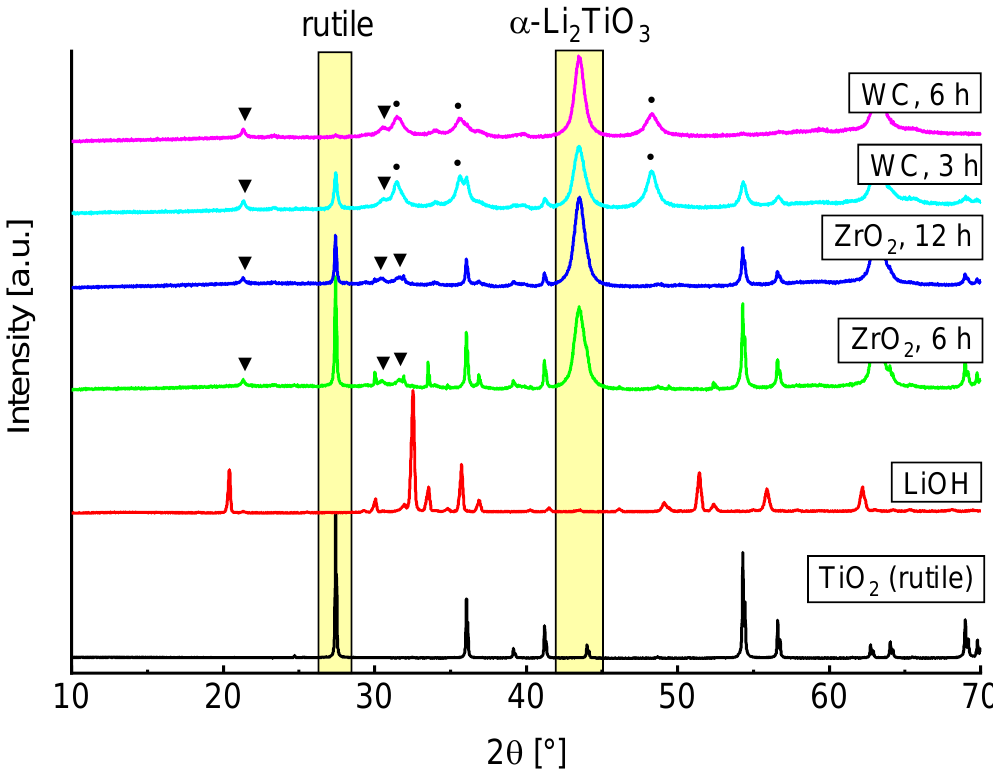
Figure 2. PXRD measurements of LiOH and rutile after different milling conditions. Excess LiOH forms Li 2 CO 3 after the milling process (triangles). WC reflections (circles) arise due to abrasion of the tools.